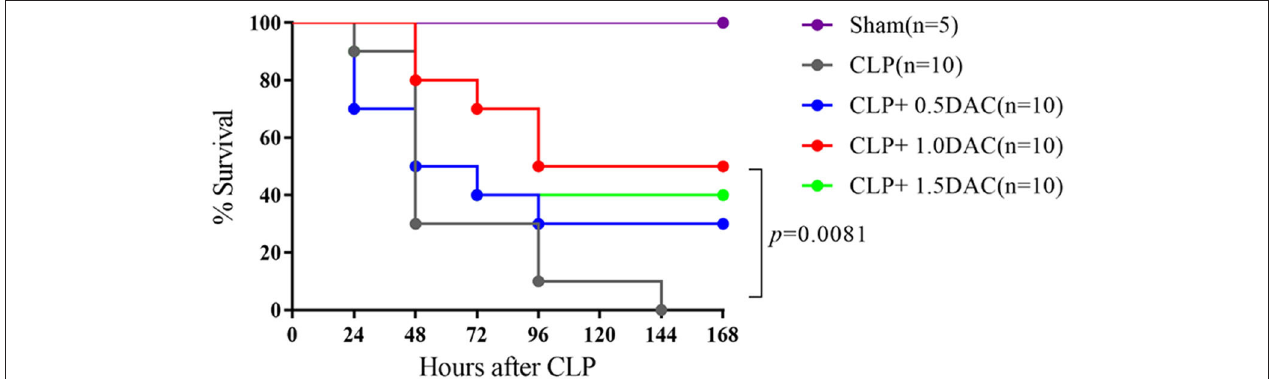
FIGURE 2 | Decitabine improved survival in severe sepsis mice induced by CLP. Survival curve after CLP of mice treated with Decitabine. Mice were injected subcutaneously with either 0.5, 1.0, and 1.5 mg/kg Decitabine (CLP + 0.5 DAC, CLP + 1.0DAC, CLP + 1.5DAC, n = 10) or PBS (CLP, n = 10) 2h after CLP and were monitored for 7 days or until death. Sham (laparotomy without CLP) groups ( n = 5) served as controls. CLP, cecal ligation and puncture; DAC, Decitabine; PBS, phosphate-buffered saline. p = 0.0081 by Log-rank test.